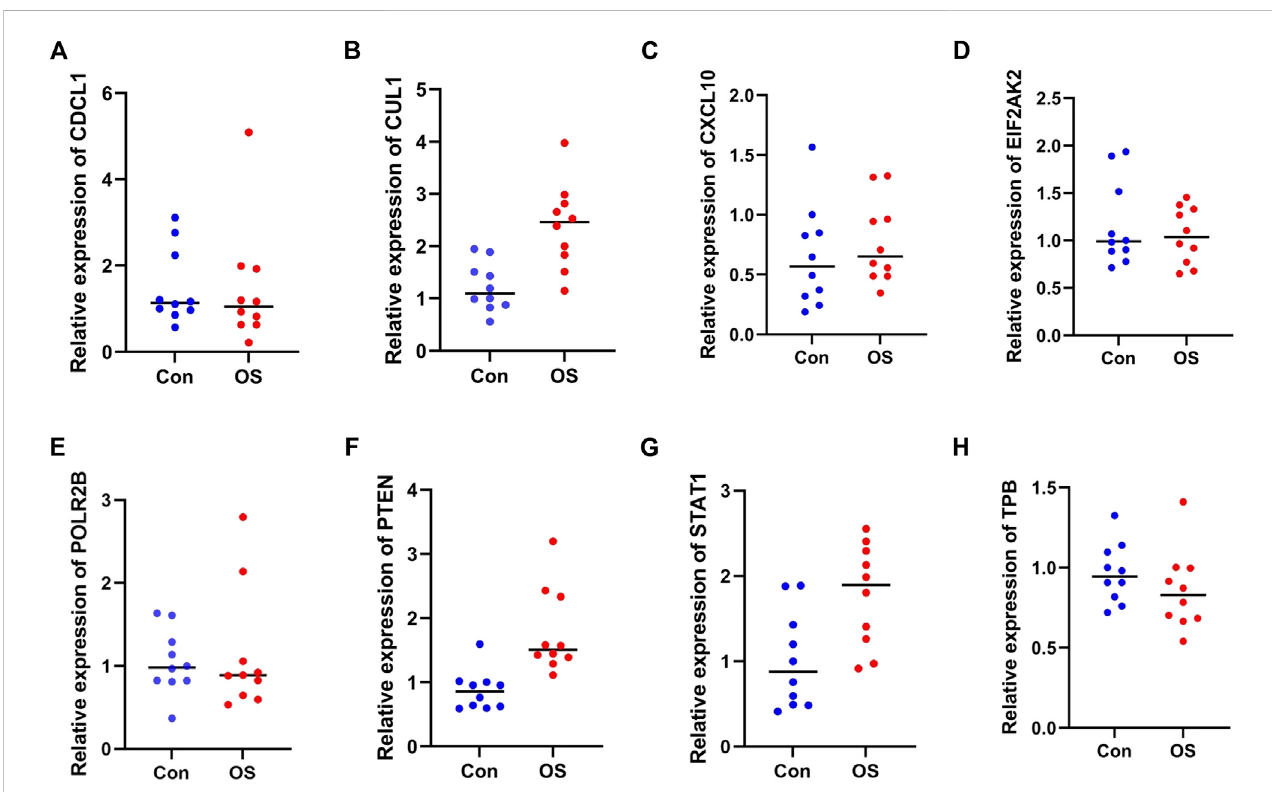
FIGURE 8 qRT-PCR validation results. (A) CDC5L, (B) CUL1, (C) CXCL10, (D) EIF2AK2, (E) POLR2B, (F) PTEN, (G) STAT1, (H) TBP. RNA expression of 8 genes were measured in OS and healthy samples. p -values were calculated using a two-sided unpaired Student ’ s t-test. ** p < 0.01; *** p < 0.00 1; **** p < 0.000